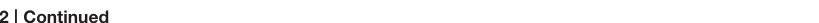
FIGURE 2 | Continued Because the deformation map was synchronously moved (same speed) with the deforming circular region, a pixel of an image on the inside of the circular region was deformed at constant magnitude by the motion vector across frames. “Pixel warp” refers to a pixel warp method (Glasbey and Mardia, 1998). “Spatial Tukey window” refers to a two-dimensional spatial window to restrict the visibility of a stimulus image in a peripheral image area. The window consists of a combination of a rectangular window with a cosine window; the rectangular window was applied to keep the original image contrast on the inside of a central circular area with a diameter of 1.92 deg, while the cosine window gradually reduced the contrast in the peripheral area. (D) Some example images demonstrating how the